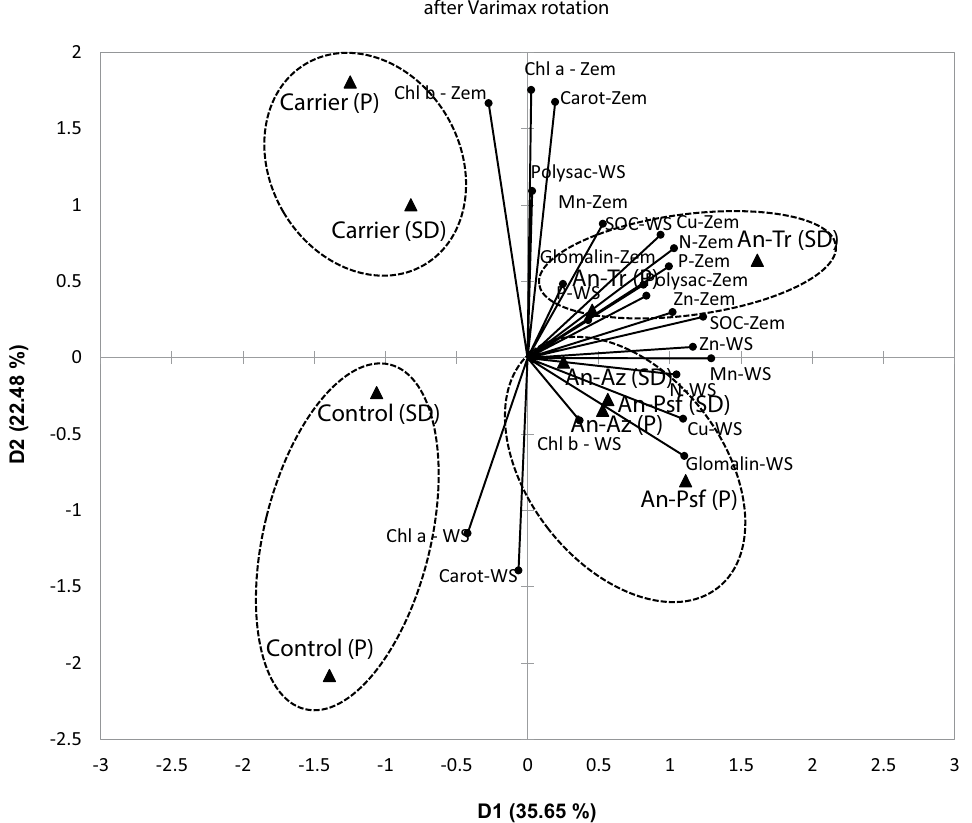
Figure 3: Principal component analysis (PCA) depicting the interactions among the plant growth attributes, soil microbiological and macro/ micronutrient parameters with the treatments in the rhizospheres of Chrysanthemum var. White Star (WS) and Zembla (Zem). The treatments include- Control, Carrier, A . torulosa - Azotobacter sp . (An-Az) biofilm, Anabaena torulosa - Pseudomonas fluorescens (An-Psf) biofilm, and Anabaena torulosa - T . viride (An-Tr) biofilm, applied as dry /powder formulation (P) or soil drench (SD) Circles illustrate the closely